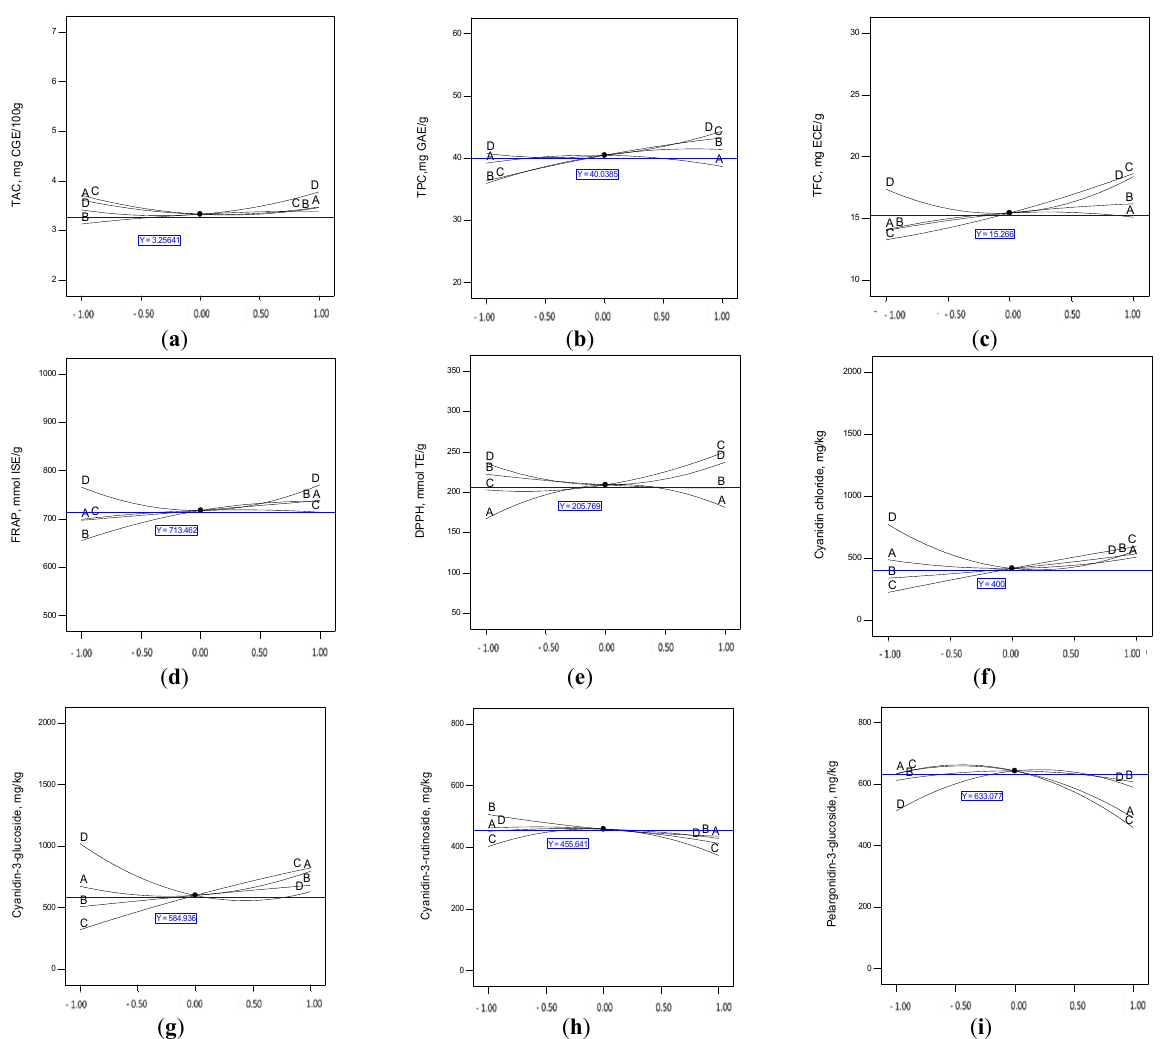
Model and terms are significant at p ≤ 0.05.The previous equations are used to gen- erate the perturbation plots (Figure 3), which helps to compare the effect of factors in one efficiency had a positive relationship with increasing temperature. FRAP analysis presented chosen point (A = 3.5, B = 30, C = 58, D = 25). A, C, B, and D represent molar ratio, water the effect of increasing water content and almost a stable effect of molar ratio and temper- content, temperature, and time, respectively. For TAC (Figure 3a), factors, the molar ratio ature variation. The antiradical scavenging capacity presented by DPPH (Figure 3e) has (A), temperature (C), and time (D) had a high extraction effect at their low and high limits been affected; positively by increasing extraction temperature and negatively by increasing and gave a weak extraction at the center point. However, water content factor (B) gave the water content. Varying the molar ratio was more efficient around the midpoint. Beyond the lowest values in low limits, which means that the extraction efficiency of TAC was very center point, extraction time was more efficient at positive and negative extremes to give weak at low water content, and after that, the effect was stabilized. Time seemed to be the highest values for TFC, FRAP, and DPPH. more effective more than other factors for long-duration treatment.